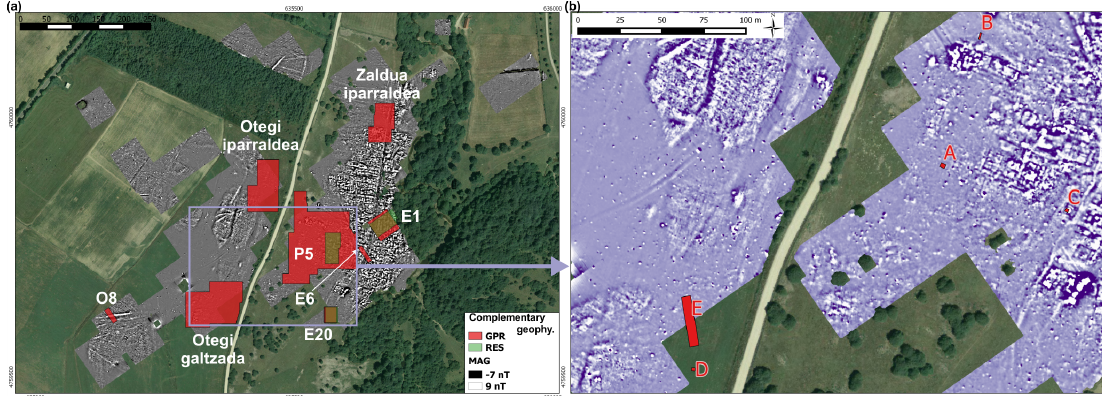
Figure 4. ( a ) Location of areas where complementary surveys (GPR and electric survey) have been performed, over the magnetic results ( − 7 nT black, 9 nT white); ( b ) Location of the archaeological trenches excavated in 2015 and 2016 over the magnetic results ( − 7 nT blue, 9 nT white)